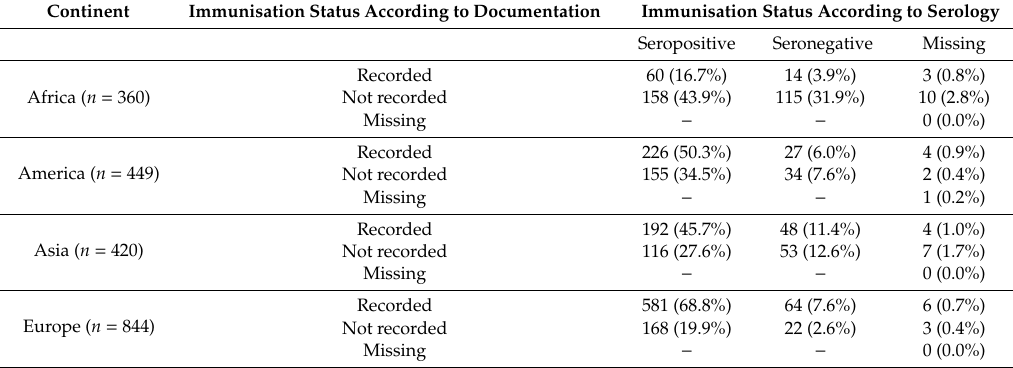
Table A3. Comparison between immunisation status of IAC reported in the documentation and serology for tetanus, by continent of